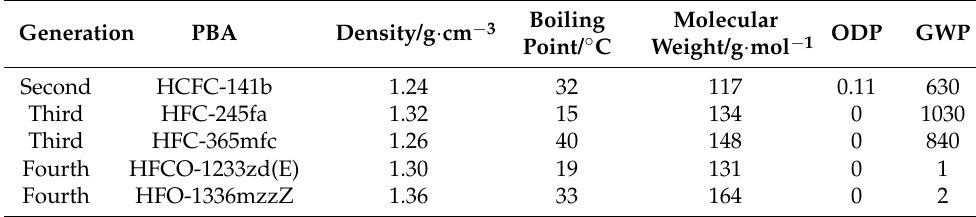
Table 1. The relevant properties associated with each generation of the PBA system.